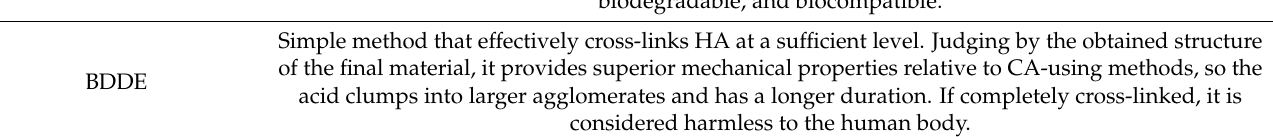
Table 4. Summary of the results of each cross-linking agent used for the cross-linking process of HA. Cross-Linking Agent Suitability Assessment/Explanations